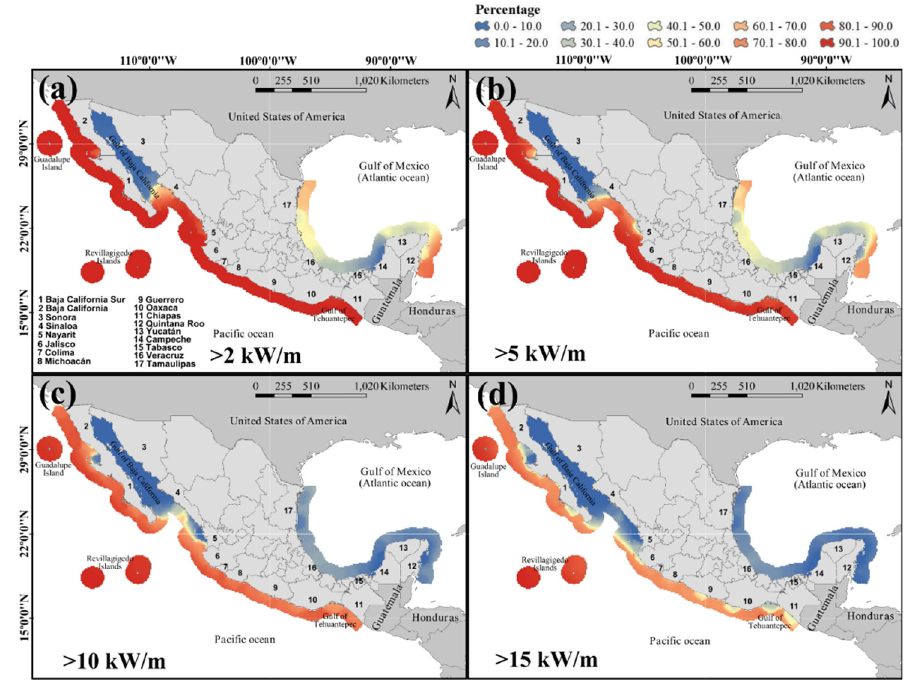
Figure 1. Theoretical results of wave power availability in Mexico (in percentages) for the ten-year period (September 2008–August 2018). Results indicate the percentage of days (over the five-year period) for this power is higher than the established thresholds. ( a ) Threshold of 2 kW / m. ( b ) Threshold of 5 kW / m. ( c ) Threshold of 10 kW / m. ( d ) Threshold of 15 kW / m.